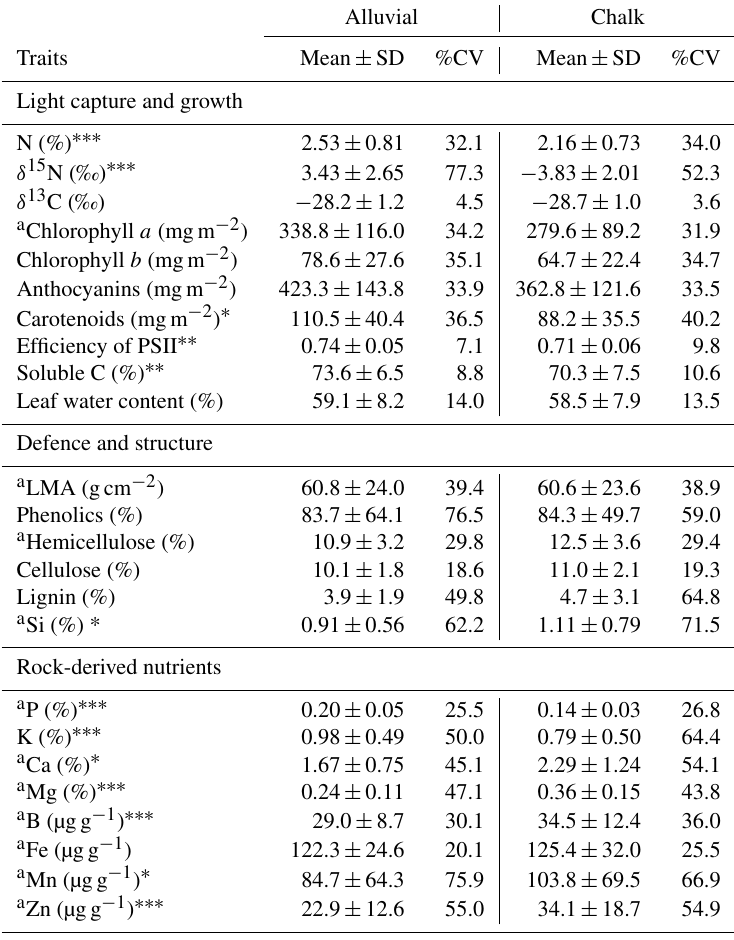
Table 1. Average, standard deviation (SD) and coefficient of variation (CV) in percentage for leaf traits of six generalist species growing on alluvial and chalk soils. Foliar trait was statistically different between soil types with P -value < 0.05 ∗ , < 0.01 ∗∗ and < 0.001 ∗∗∗ . Note that water content and the concentrations of defence and structure compounds are invariant of soil type, as this is key to understanding why variation in elemental concentrations between soil types cannot be predicted indirectly by constellation